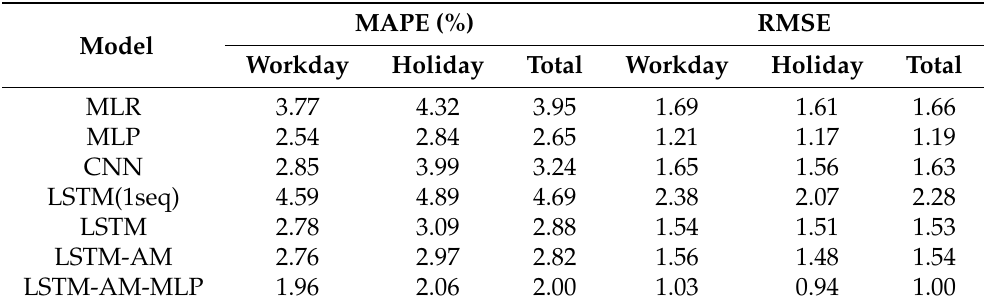
Table 8. Evaluation indices of the validation set (4 April 2019 ∼ 31 December 2019) under differ- ent models.